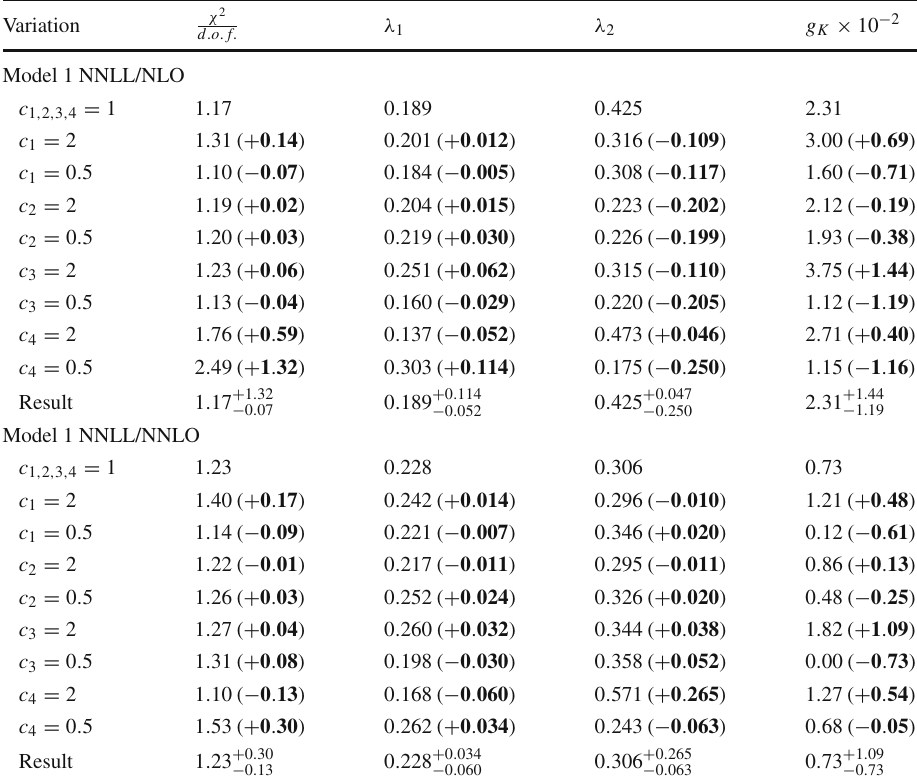
Table 14 Example of parameter extraction with the variation of c 1 , 2 , 3 , 4 constants, and evaluation of the theoretical error. Bold numbers in brackets represent the deviation of the parameter from its central